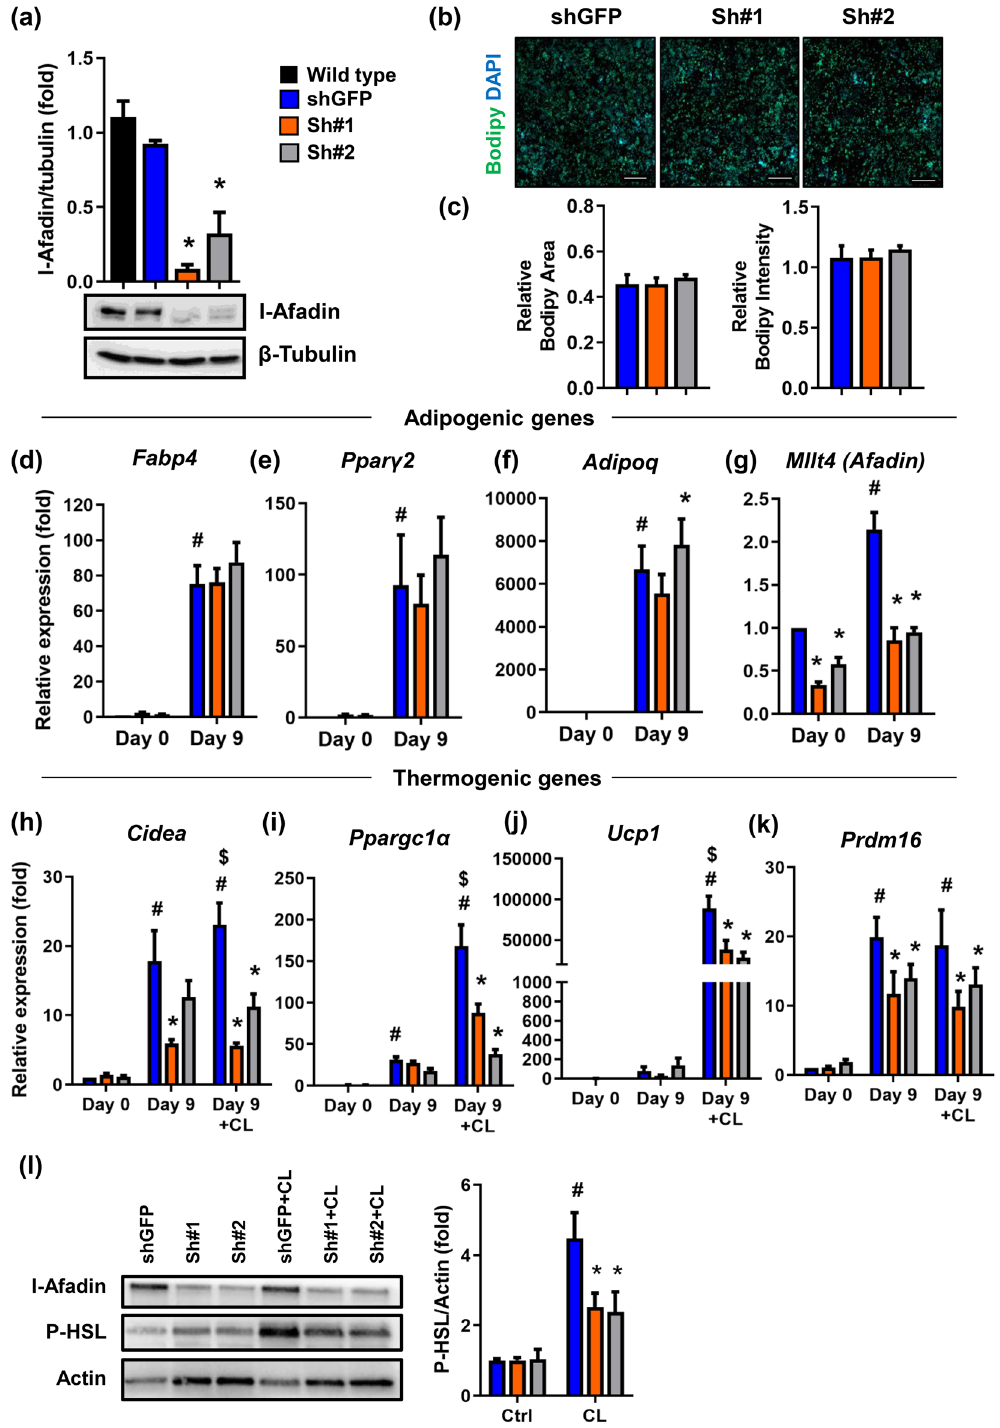
Figure 2. Afadin regulates expression of thermogenic genes in vitro. ( a ) Two stable Mllt4 shRNA- expressing preadipocyte cell-lines (sh#1 and sh#2) and a GFP shRNA-expressing control preadipocyte cell line (shGFP) were established and knockdown of Afadin confirmed at the protein level. Representative blots are shown. ( b + c ) Quantification of Bodipy-staining in differentiated cells. RT-qPCR analysis at day 0 and 9 of differentiation of ( d ) Fabp4 mRNA, ( e ) Pparγ2 mRNA, ( f ) Adipoq mRNA and ( g ) Mllt4 mRNA. Mature adipocytes were stimulated with vehicle or 5 μM CL 316,243 (CL) for 4 h. RT-qPCR analysis at day 0 and day 9 of differentiation with or without CL stimulation of ( h ) Cidea mRNA, ( i ) Ppargc1α mRNA, ( j ) Ucp1 mRNA and ( k ) Prdm16 mRNA. ( l ) Immunoblotting from mature adipocytes exposed to vehicle or CL 316,243 for 4 h. N = 3–4. Data are presented as means + SEM, *p < 0.05 vs. shGFP, # p < 0.05 vs. Day 0, $ p < 0.05 vs. Day